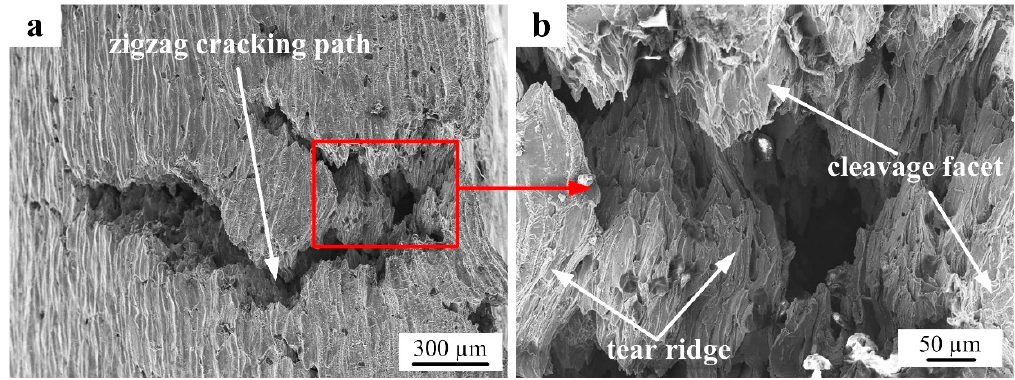
Figure 5. SEM images showing cracking morphology on the compressed PM Ti-5553 alloy specimen at 700 °C/10 s − 1 .